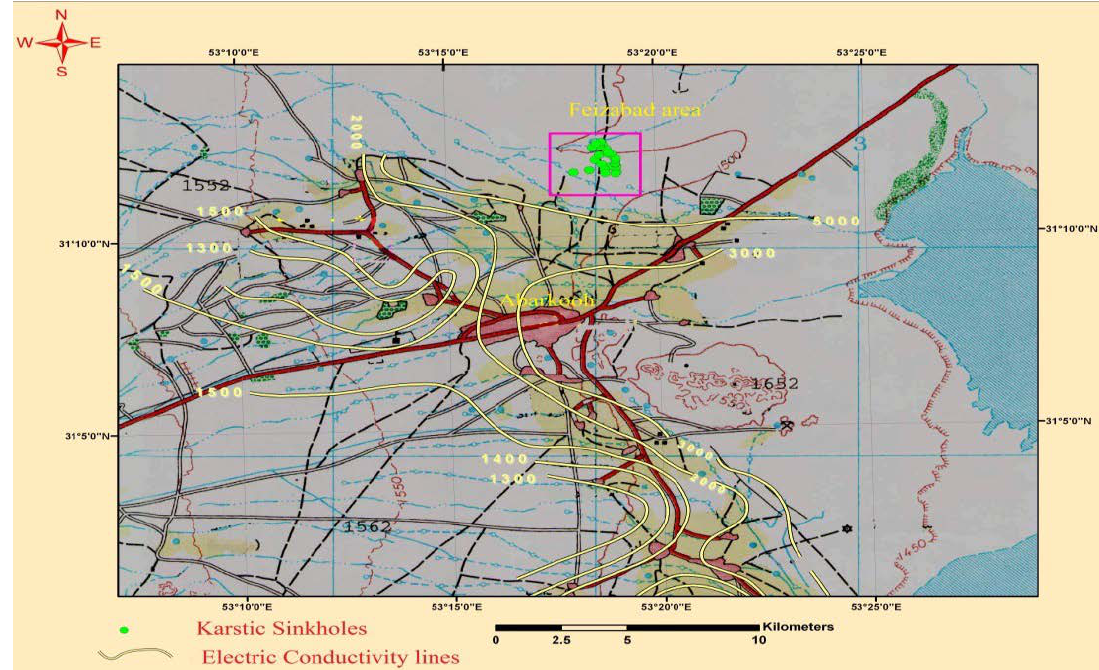
Figure 12. Electric conductivity lines of groundwater sources in the Abarkooh plain from 2000.